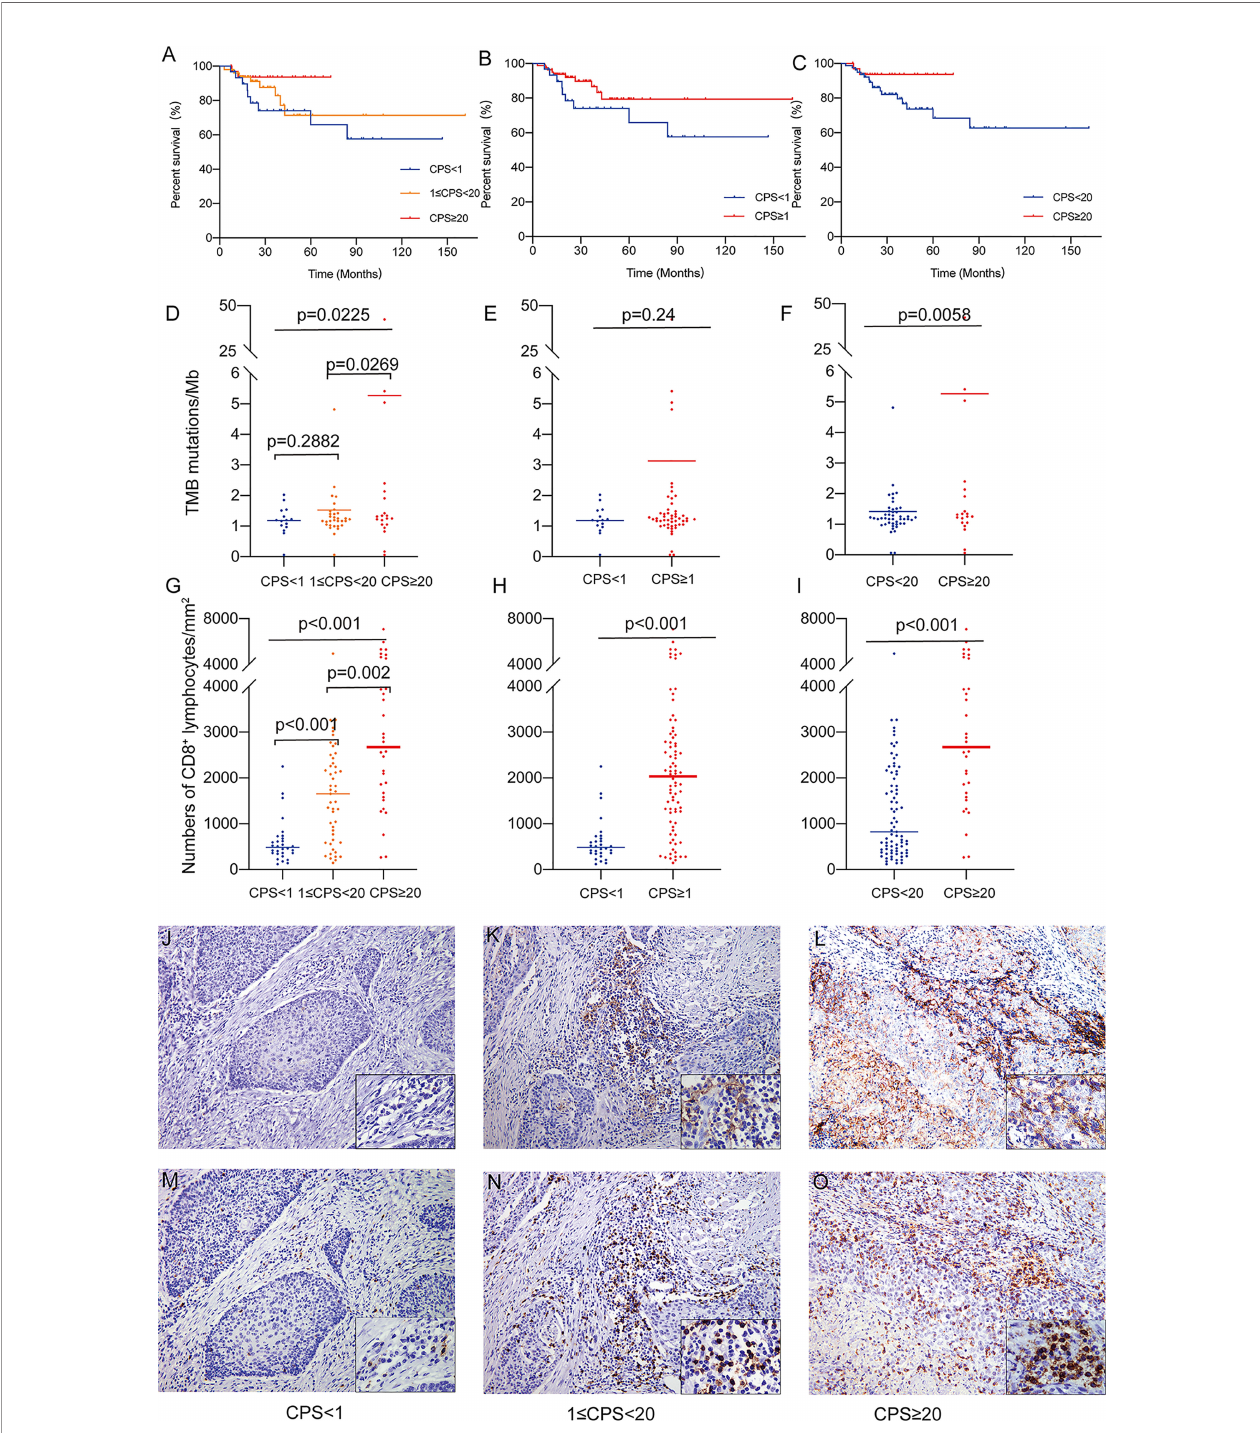
FIGURE 1 | (A) Overall survival of patients classi fi ed by methodology A. (B) Overall survival of patients classi fi ed by methodology B. (C) Overall survival of patients classi fi ed by methodology C. (D) The association of TMB as a continuous variable and PD-L1 CPS classi fi ed by methodology A. (E) The association of TMB as a continuous variable and PD-L1 CPS classi fi ed by methodology B. (F) The association of TMB as a continuous variable and PD-L1 CPS classi fi ed by methodology C. (G) The association of CD8+ TILs density and PD-L1 CPS classi fi ed by methodology A. (H) The association of CD8+ TILs density and PD-L1 CPS classi fi ed by methodology B. (I) The association of CD8+ TILs density and PD-L1 CPS classi fi ed by methodology C. (J) PD-L1 staining (CPS<1, 200X). (K) PD-L1 staining (1<CPS ≤ 20, 200X). (L) PD-L1 staining (CPS ≥ 20, 200X). (M) CD8 staining (CPS<1, 200X). (N) CD8 staining (1<CPS ≤ 20, 200X). (O) CD8 staining (CPS ≥ 20,